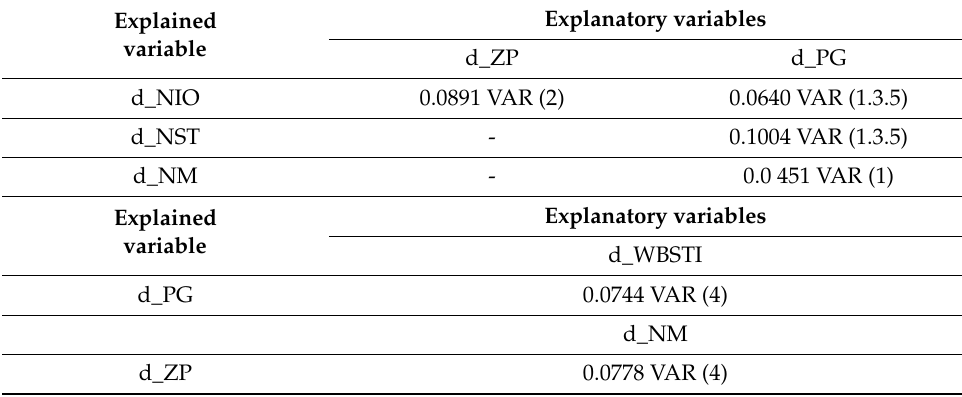
Table 3. Causal correlations—the p -value, and essential government delays. Explained variable